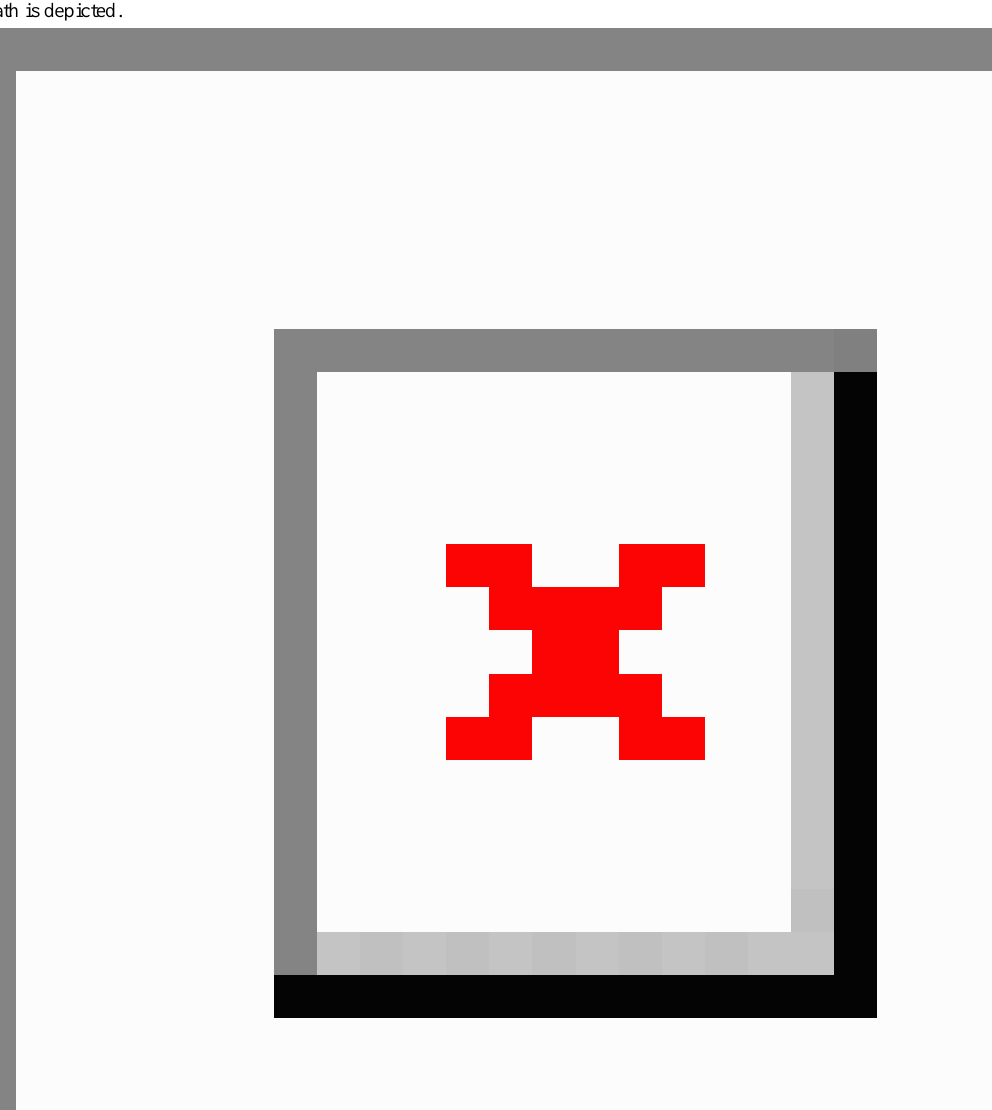
Figure 1. Target pattern (left) and distractor patterns surrounding target pattern (right). Areas of interest for eye tracking are marked, and theoretical gaze path is